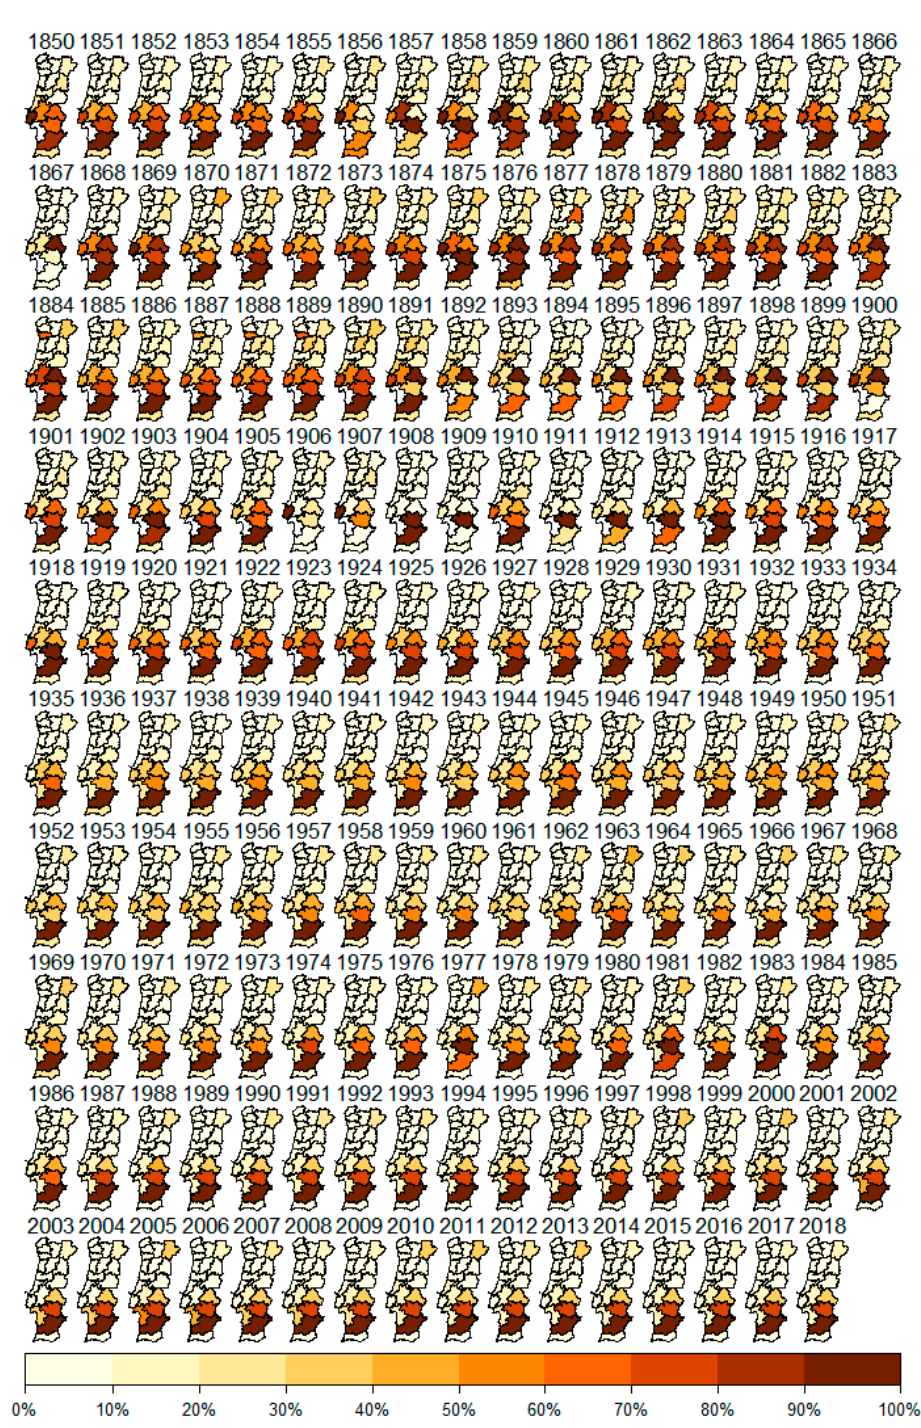
Figure 7. Spatiotemporal pattern of wheat production (1850–2018).